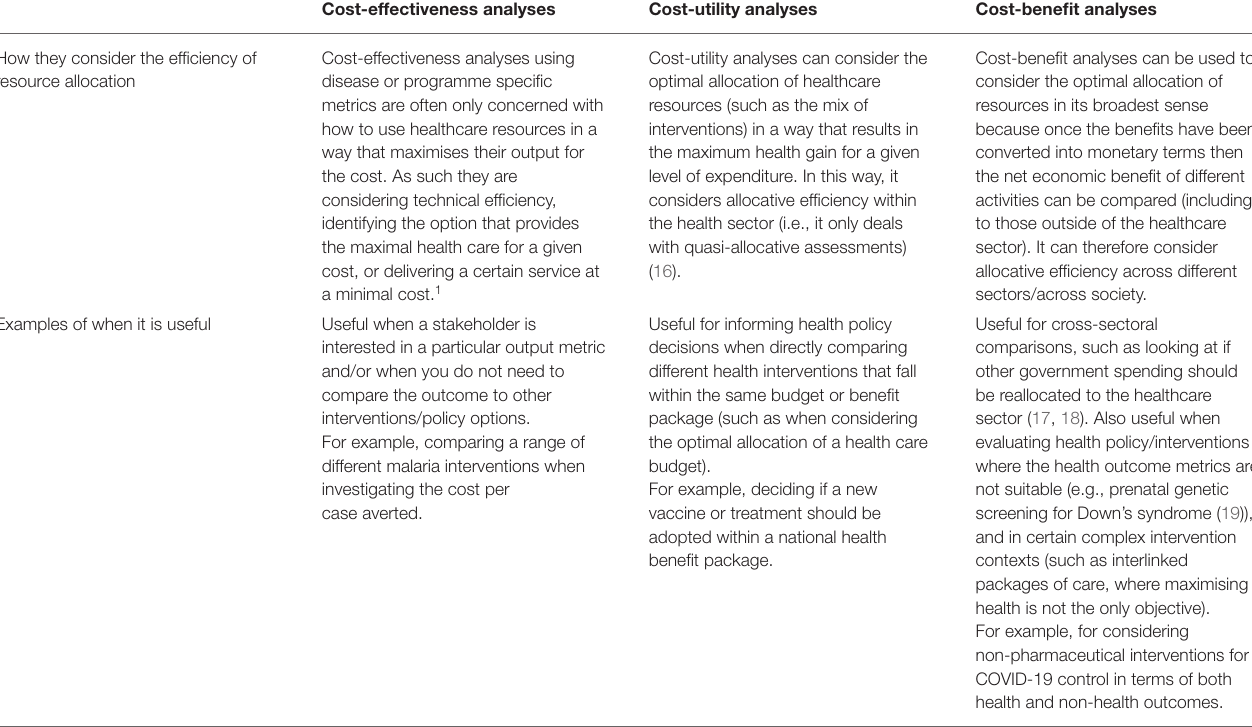
TABLE 2 | A summary of how the different types of analyses consider the efficiency of resource allocation and examples of their